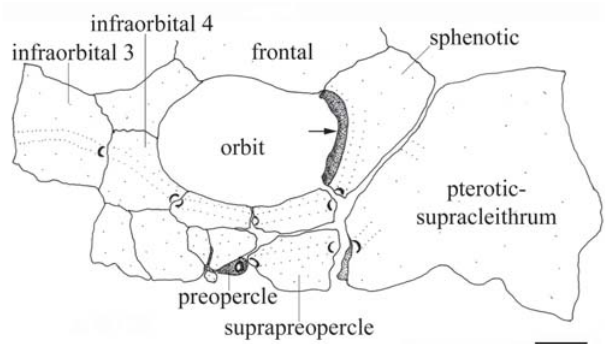
Fig. 19. Lateral view of left side of bones surrounding orbit of Rineloricaria sp. (MZUSP 23748, 91.5 mm SL). Arrow points to orbital notch. Scale bar = 1